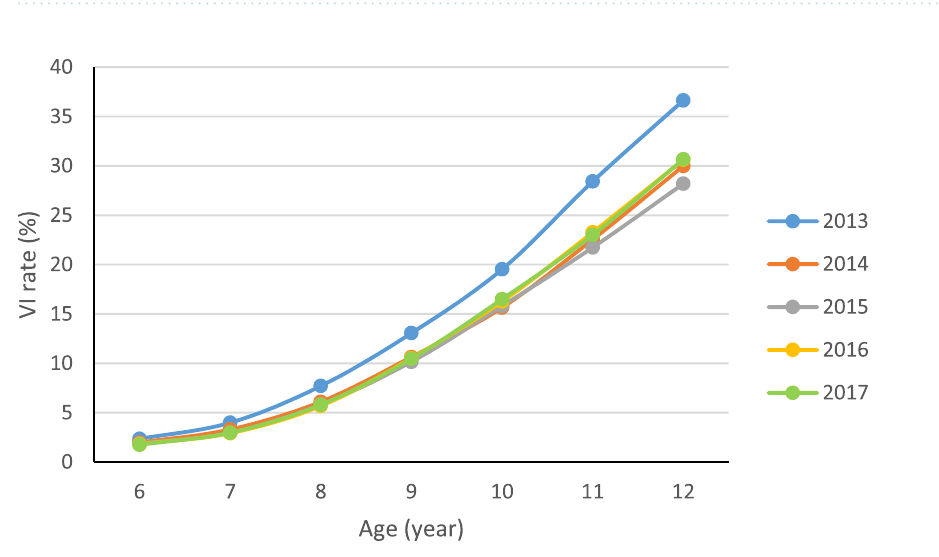
Figure 3. Age trends of visual impairment (VI) among children in Shandong province from 2013 to